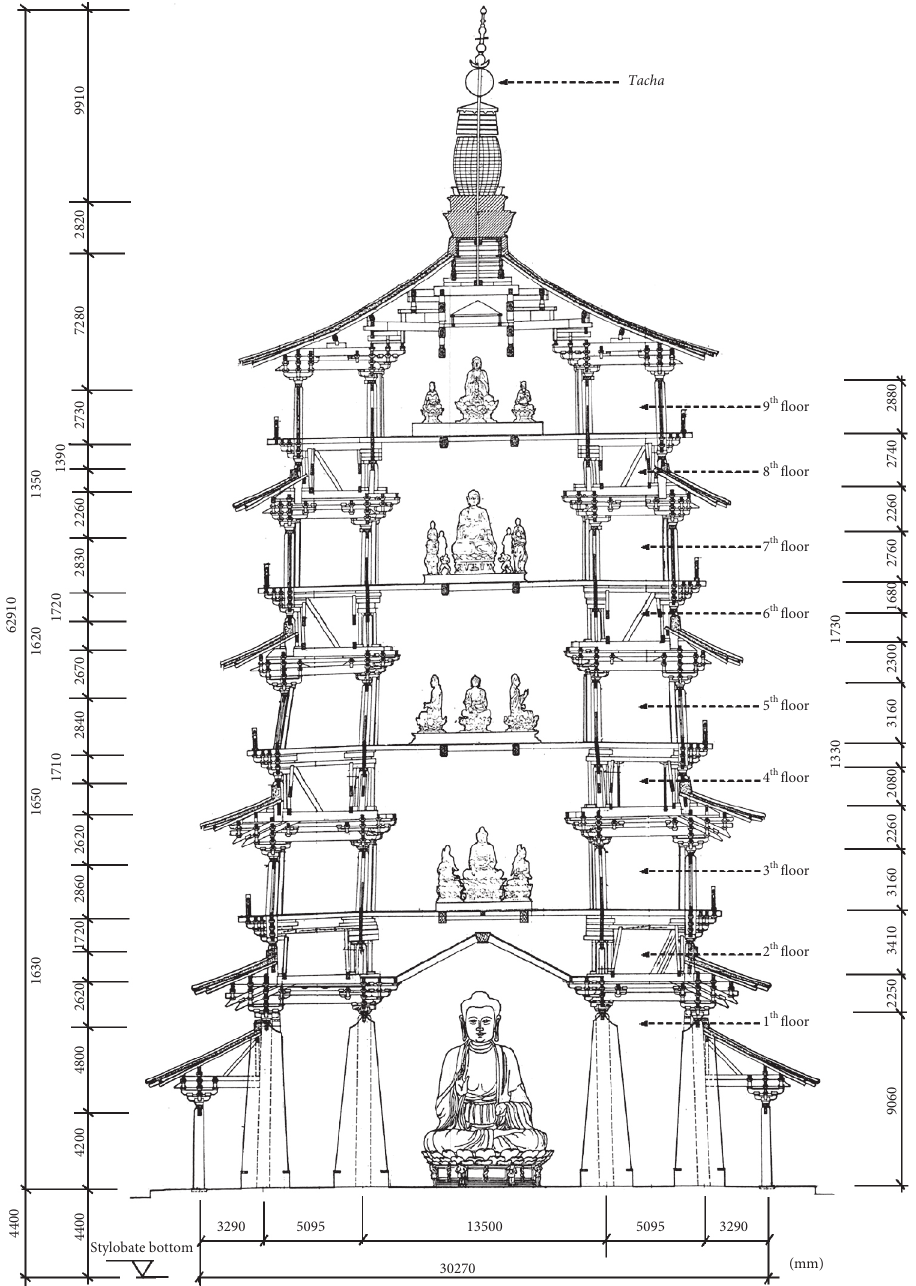
Figure 3: Elevation view of Yingxian Wood Pagoda. The elevations on the right and left indicate the outer and inner columns,